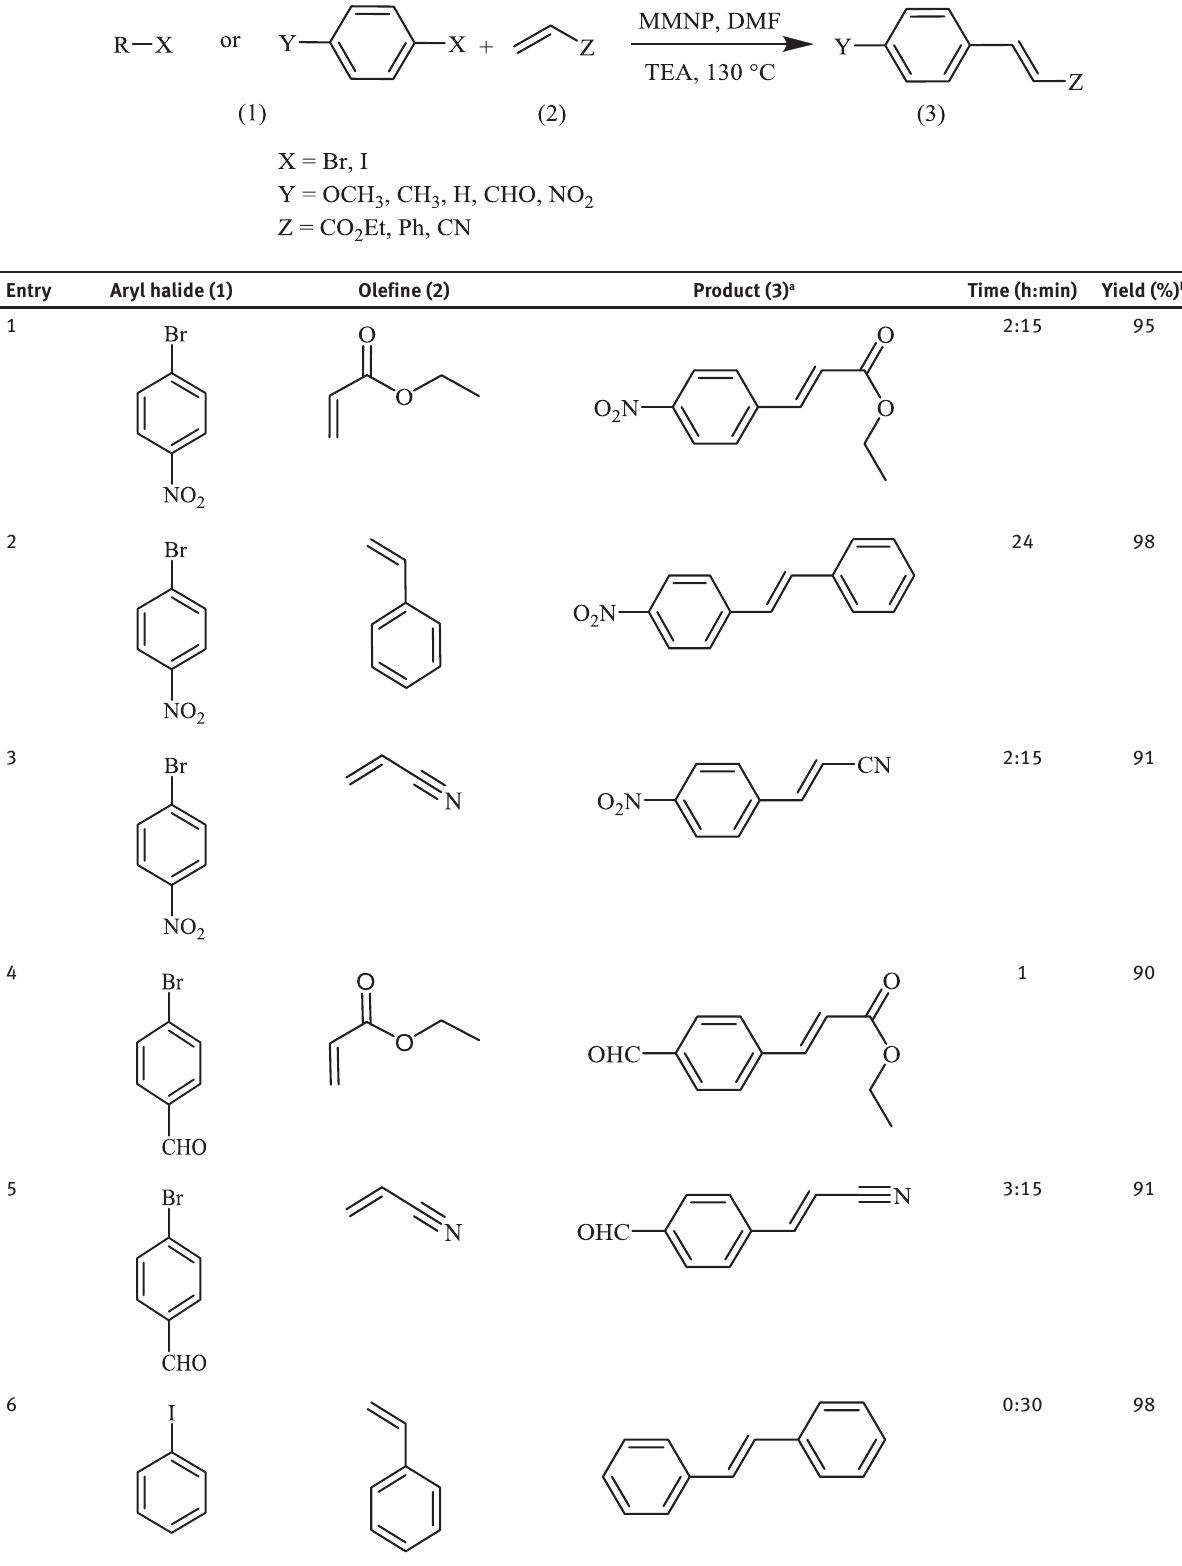
Table 5: The Heck reaction of various alkyl and aryl halides and olefins in the presence of MMNP as a catalyst.